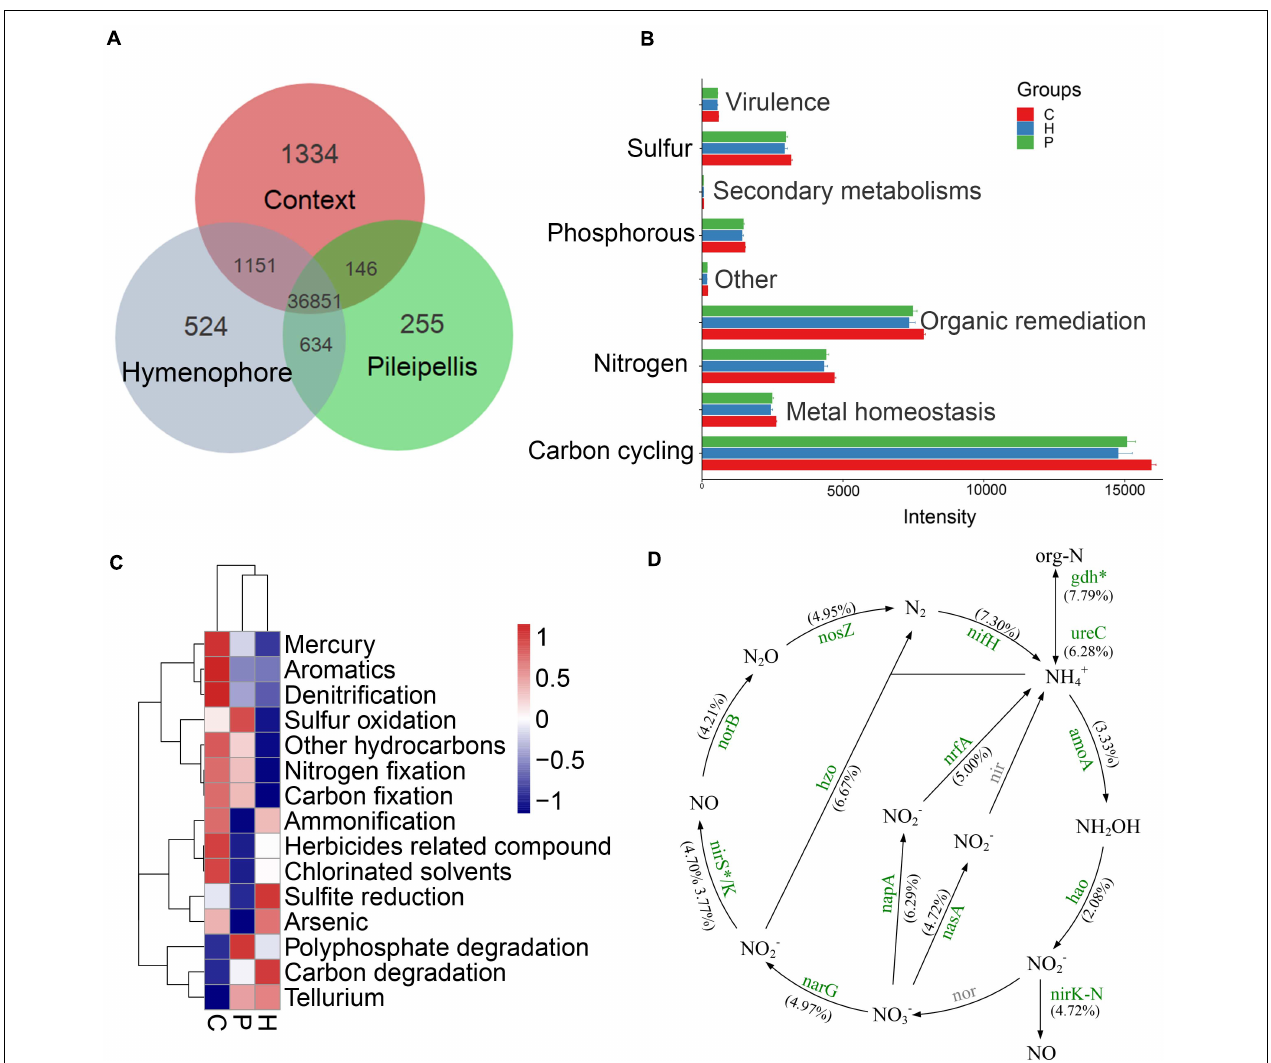
FIGURE 4 | GeoChip analyses of key functional genes of microbial communities in Thelephora ganbajun tissue compartments (C, context; H, hymenophore; P, pileipellis). (A) Shared and unique functional genes; (B) gene category ANOVA barplots with significant differences ( P < 0.05); (C) top 15 gene subcategory heatmap (colors show mean values, n = 3); (D) nitrogen cycling analysis from GeoChip data (as no significant differences between H and P, nitrogen cycling comparison was made only between C and H). The percentage change in N-related gene intensity between the context and hymenophore is indicated in parenthesis. Increased gene intensities in the context are labeled in green and significance is marked with * P < 0.05. The gray color genes are not targeted by GeoChip